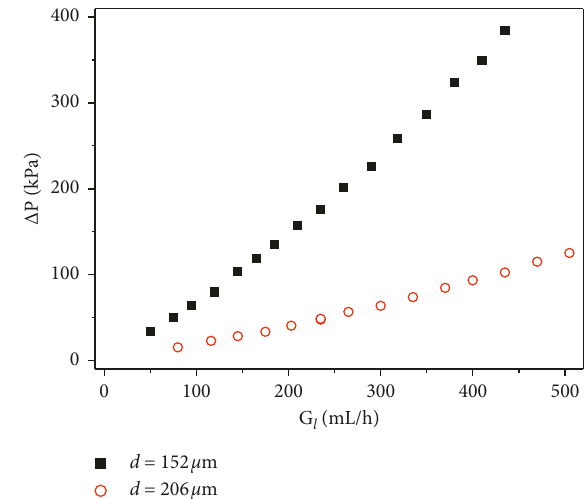
Figure 7: Pressure drop of liquid flow in microchannels at different flow rates ( T � 40 ° C, L � 7.2cm).